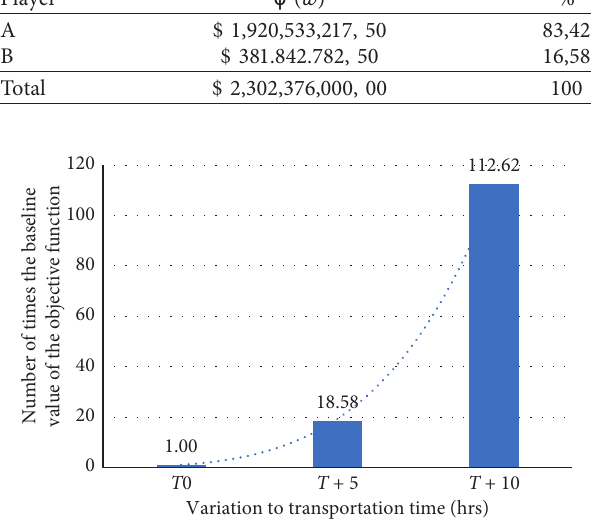
Figure 5: Sensitivity analysis performed on delivery times.